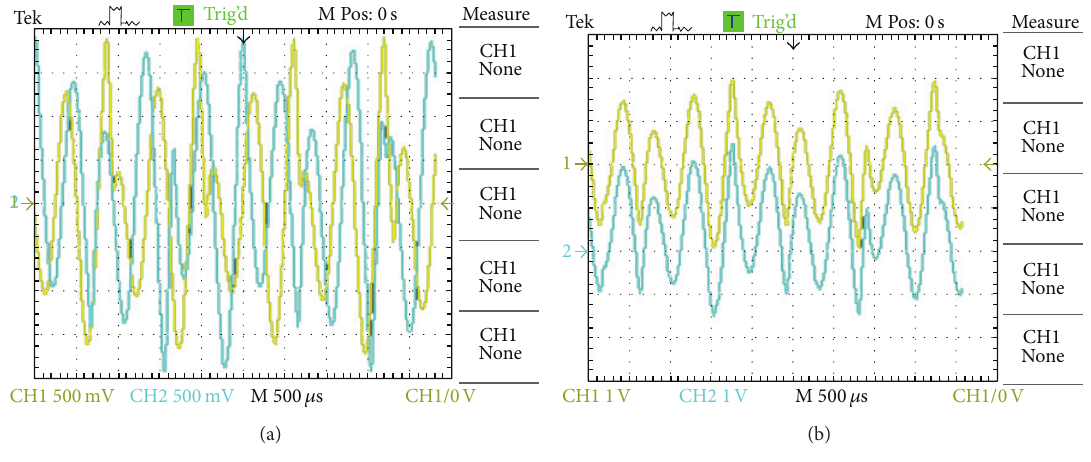
Figure 8: Time-domain chaotic waveforms of the transmitter and receiver circuits and with the synchronization circuit: (a) deactivated and (b) activated.